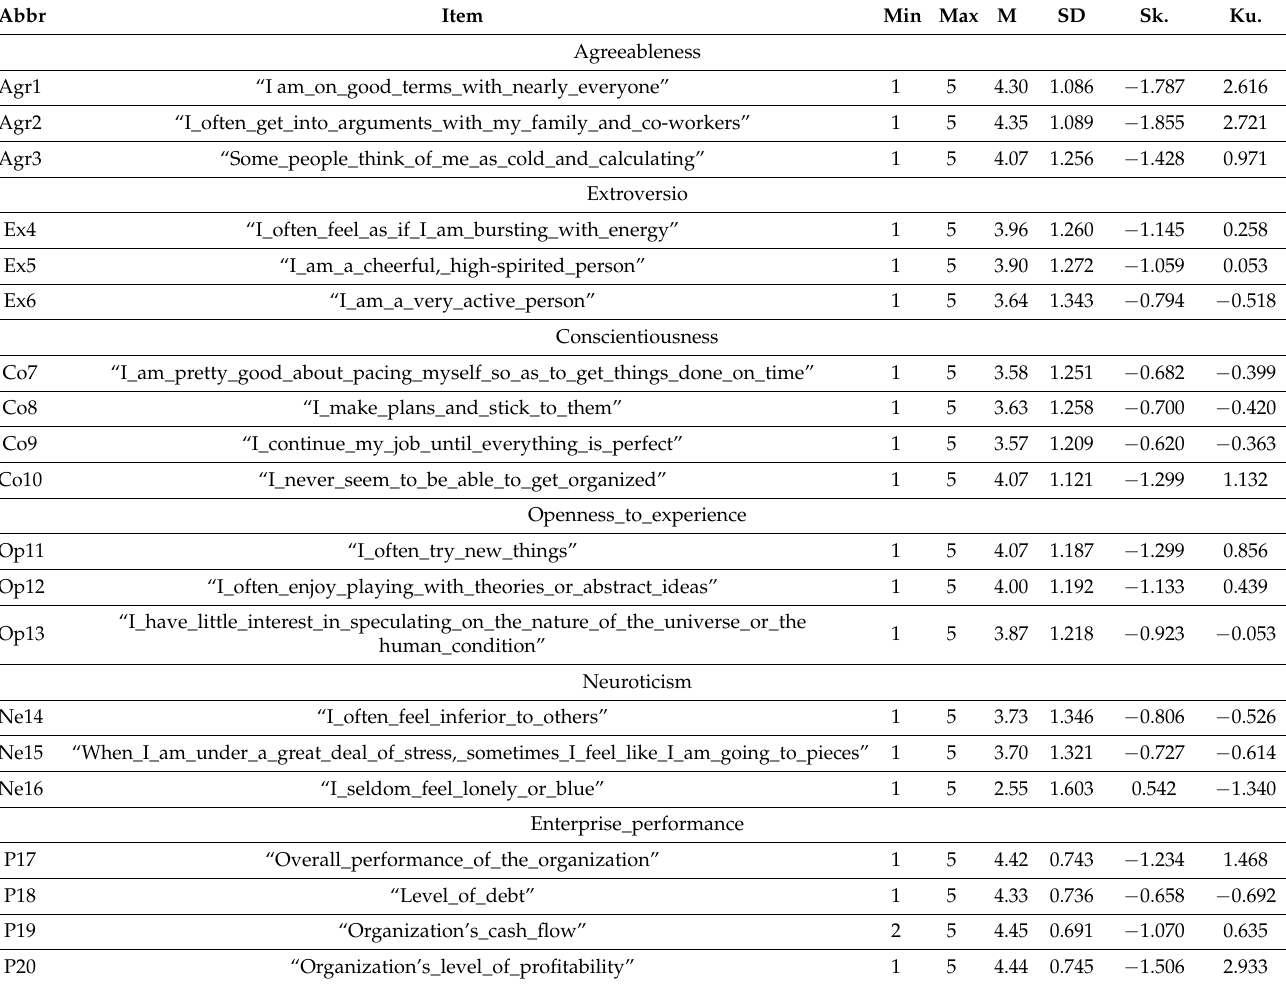
Table 1. Minimum, Maximum, Mean, Standard Division, Skewness and